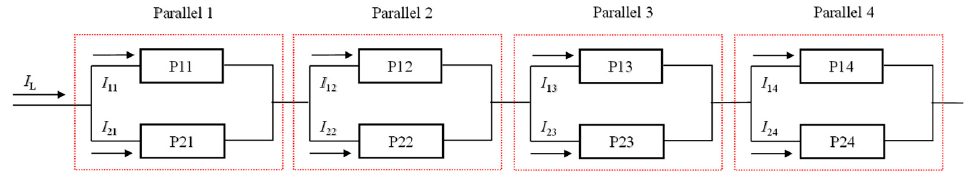
Figure 10. The topology of the 2P4S-based ba tt ery pack.